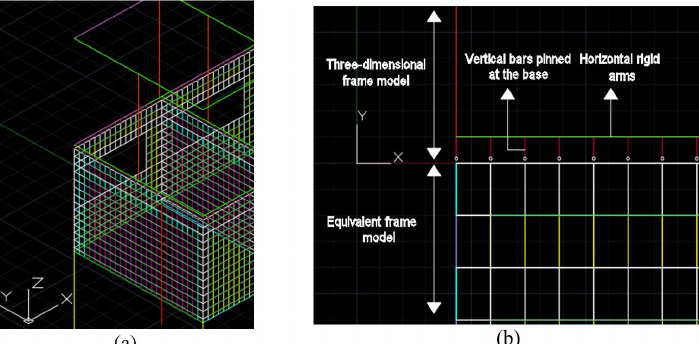
Figure 3. Connection between the equivalent frame and three-dimensional frame model: (a) General overview of first, second and third floors; (b) Connection